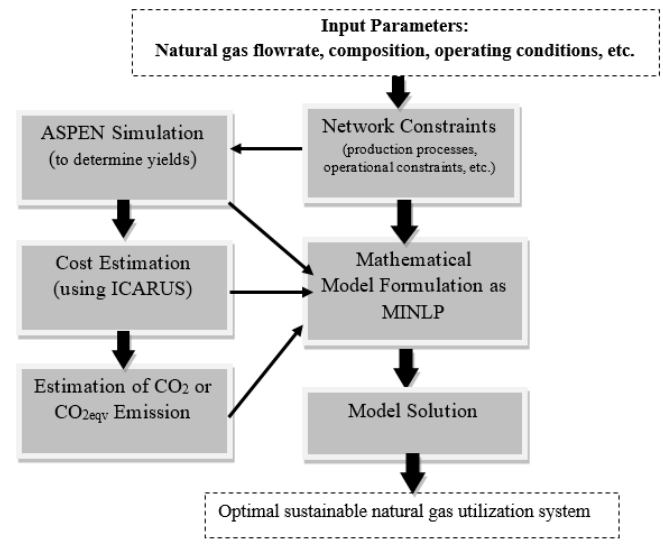
Figure 2. General solution strategy for sequential use of simulation and optimization for natural gas utilization system. Table 1. Different possible technologies & operating modes considered in the superstructure.